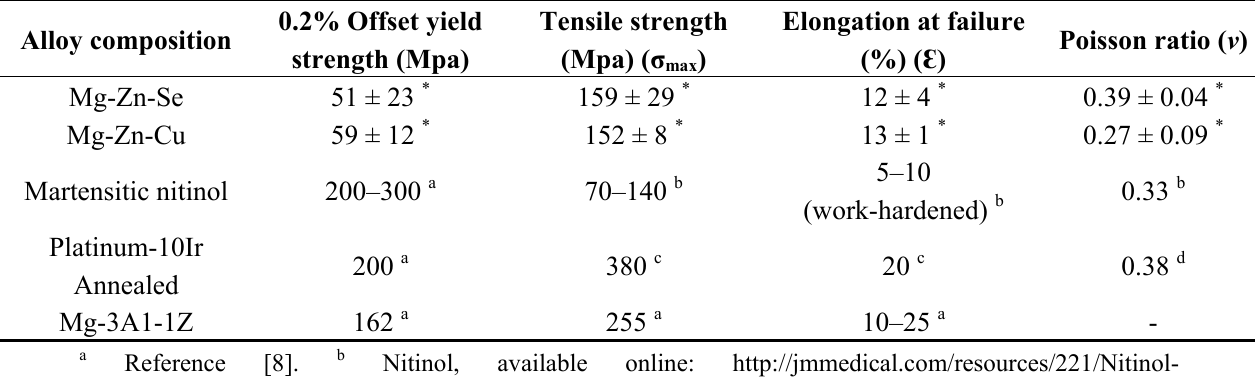
Table 2. Tensile properties of ternary magnesium alloys at room temperature (25